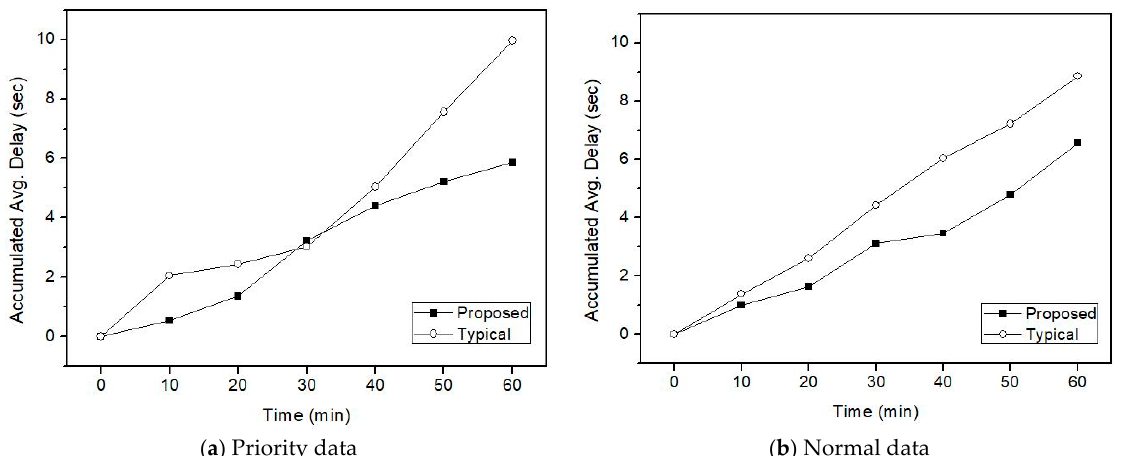
Figure 9. Transmission delay when p is 0.5 and IoV high ‐ priority is 30%.